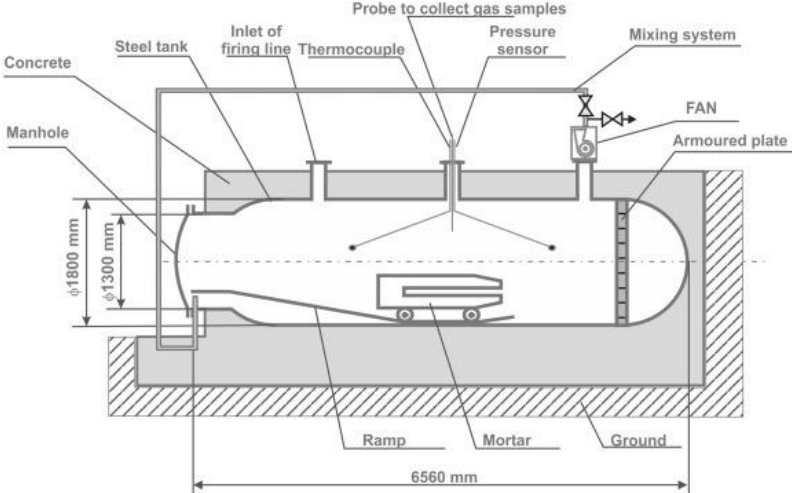
Figure 1. Blasting chamber [27].